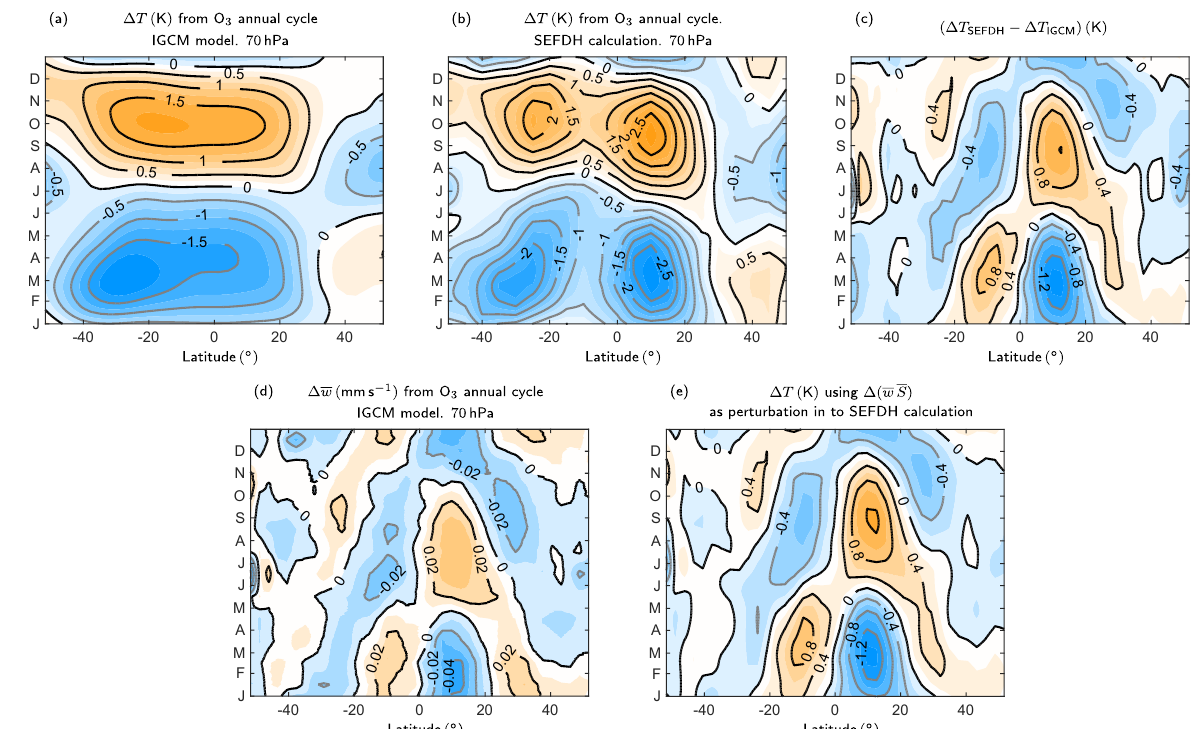
Figure 10. (a) Monthly temperature changes showing the annual cycle at 70hPa calculated using the idealized dynamical model (IGCM) with an annual cycle in ozone. (b) Figure 2b is reproduced here for comparison and shows the corresponding SEFDH calculation at 70hPa. (c) Difference in temperature change (K) between SEFDH calculation (b) and the IGCM calculation (a) . (d) Change in upwelling in idealized dynamical model. (e) Temperature change at 70hPa calculated by imposing the term (cid:49)(wS) from the dynamical model as a perturbation to the SEFDH calculation. See main text for more